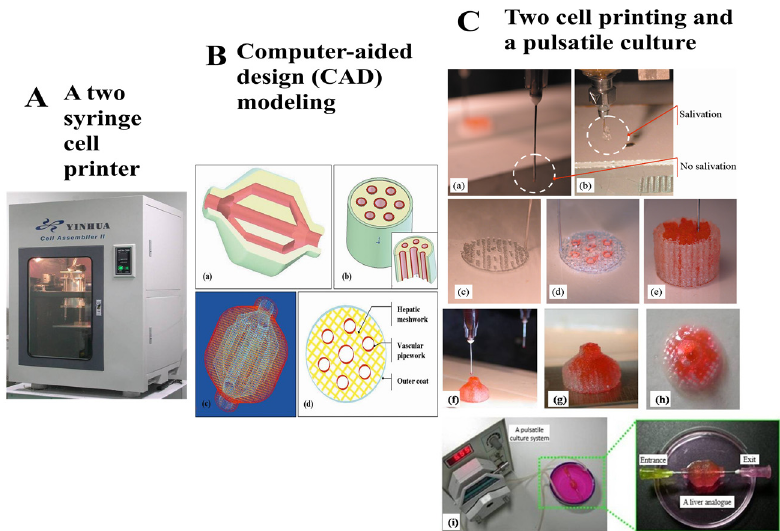
Figure 2. A two-nozzle 3D bioprinting technique developed in Tsinghua University Prof. Wang’s group. Two different cell types in the gelatin-based hydrogels have been assembled simultaneously into a construct [10]. ( A ) The two-syringe/nozzle cell printing machine; ( B ) A computer-aided design